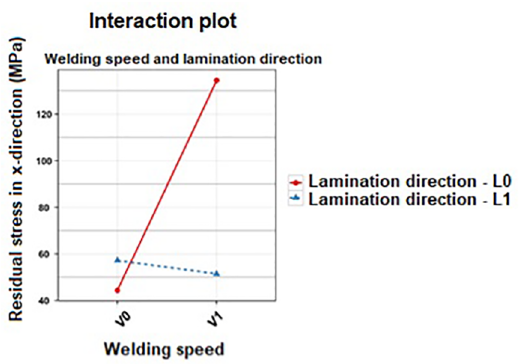
Figure 4. Graph of interactions of welding speed and lamination direction in the residual stress in X